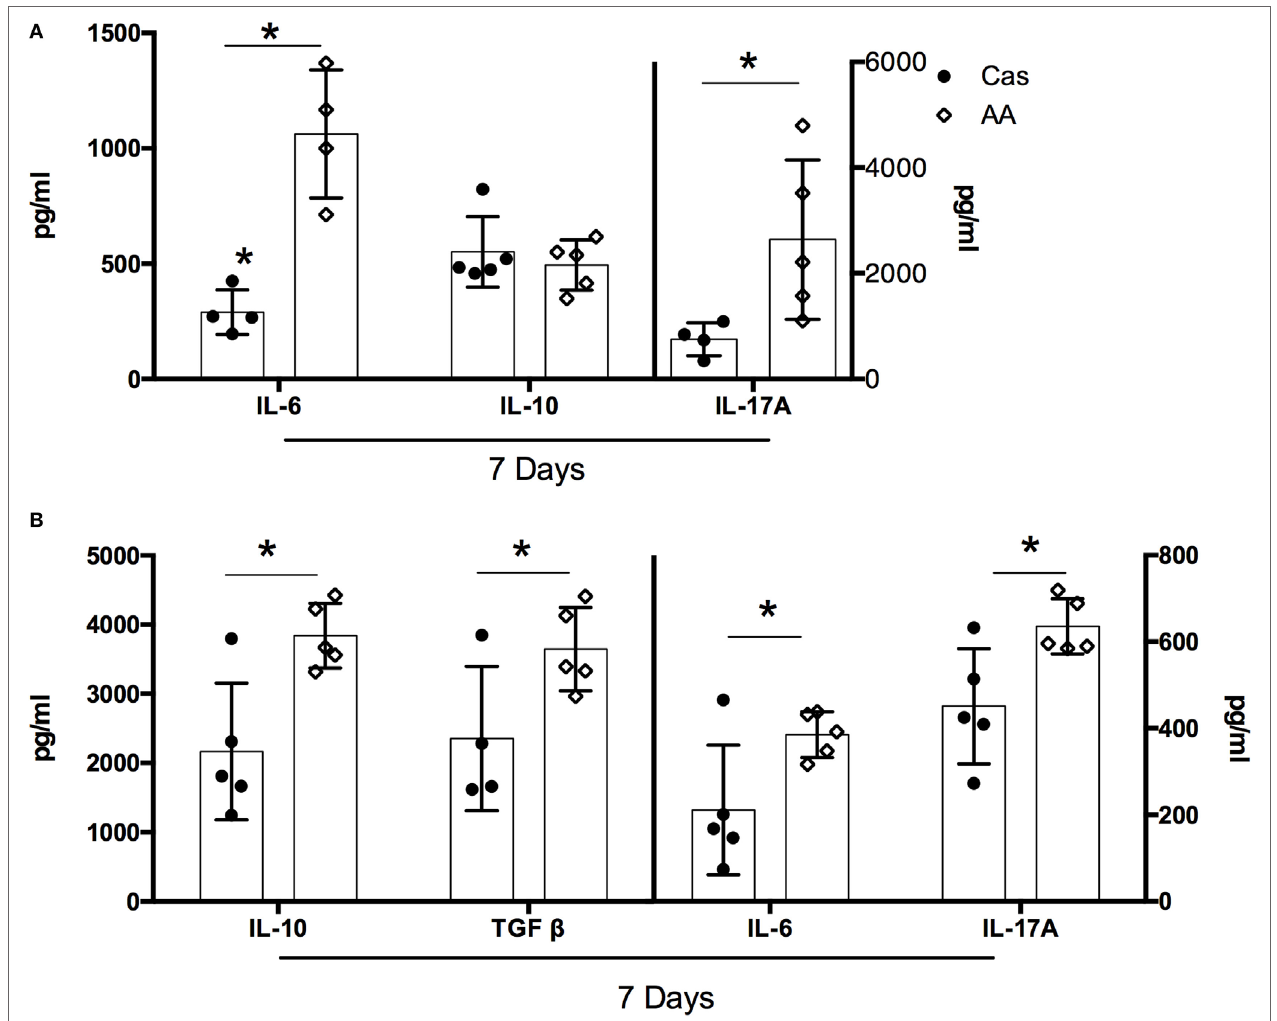
FigUre 2 | Cytokines levels in the small intestine and colon after dietary consumption. C57BL/6 mice at 7–8 weeks of age were fed either experimental diet [diet containing free amino acids (AA diet)] or control diet [casein-containing diet (CAS diet)] for 5 weeks. Levels of IL-6, IL-17A and IL-10 were measured in the small intestine (a) , and levels of IL-10, TGF- β , IL-6, IL-17A, IL-12, IL-4, and IFN- γ were measured in the colon (b) by enzyme-linked immunosorbent assay (ELISA) after 7 days of dietary consumption ( n = 4–7). Statistical analysis was performed between CAS-fed and AA-fed group. p <